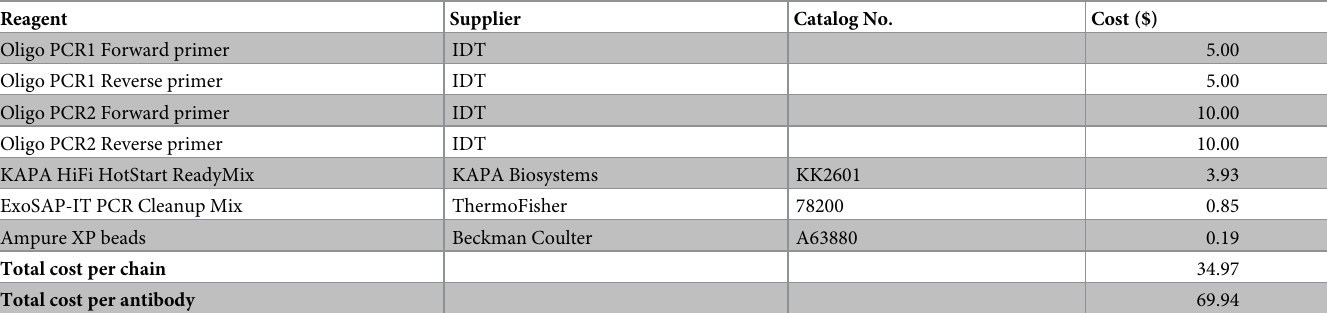
Table 1. Cost analysis of Selective PCR for Antibody Retrieval (SPAR).